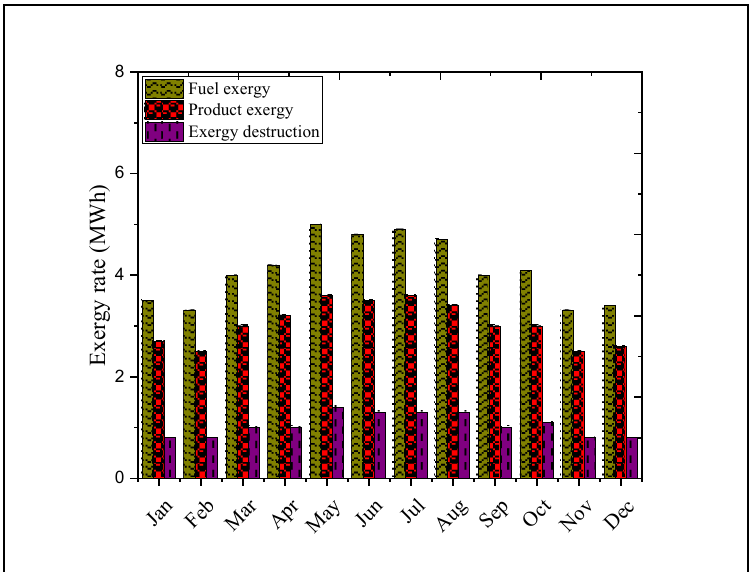
Figure 8. Amount of exergy of the incoming flow, exergy of the outgoing flow and destroyed exergy for the months of the year.